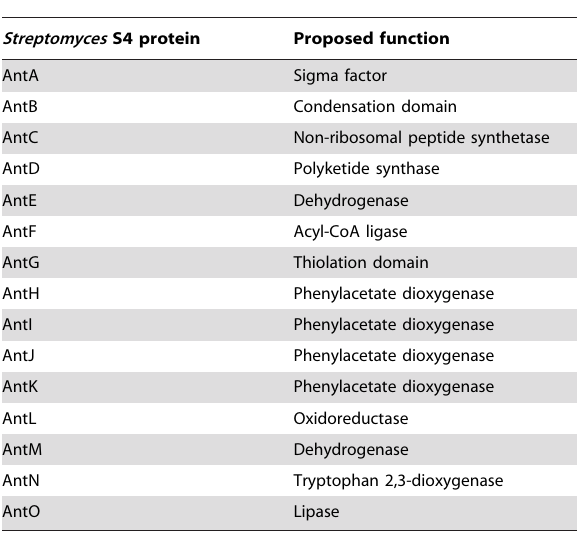
Table 2. Proposed functions of proteins encoded by the antimycin biosynthetic gene